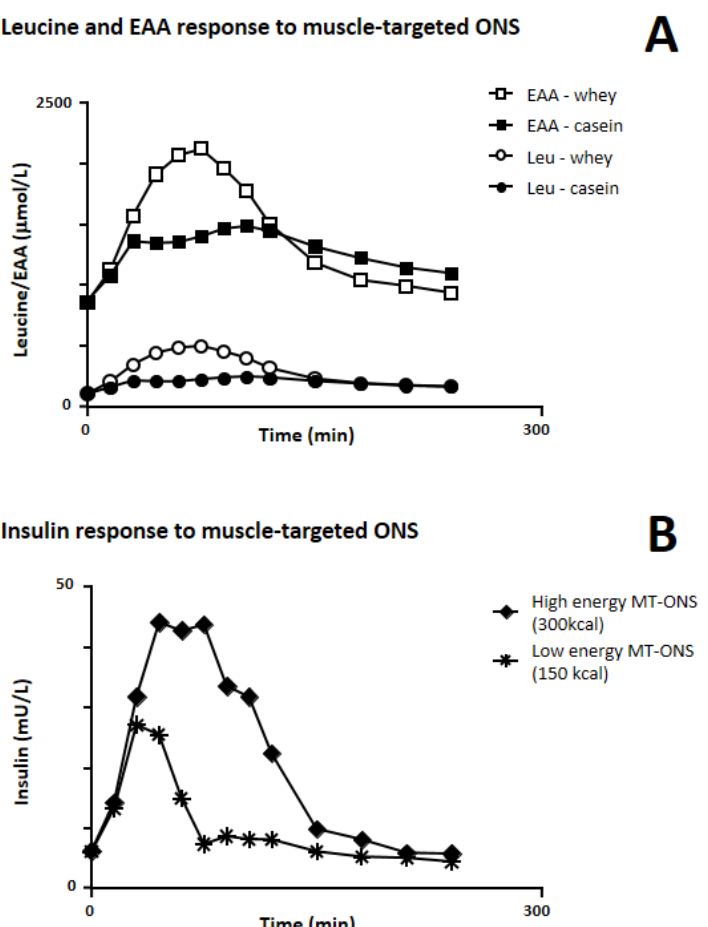
Figure 1. Serum levels (in healthy older subjects) of: ( A ) leucine (Leu) and essential amino acids (EAA) in response to the ingestion of a low-calorie (150 kcal) casein-based and leucine-enriched whey-protein-based (muscle-targeted) ONS; ( B ) insulin in response to the ingestion of a low-calorie (150 kcal) and a high-calorie (300 kcal) muscle-targeted ONS (MT-ONS). Adapted from the study by Luiking et al.